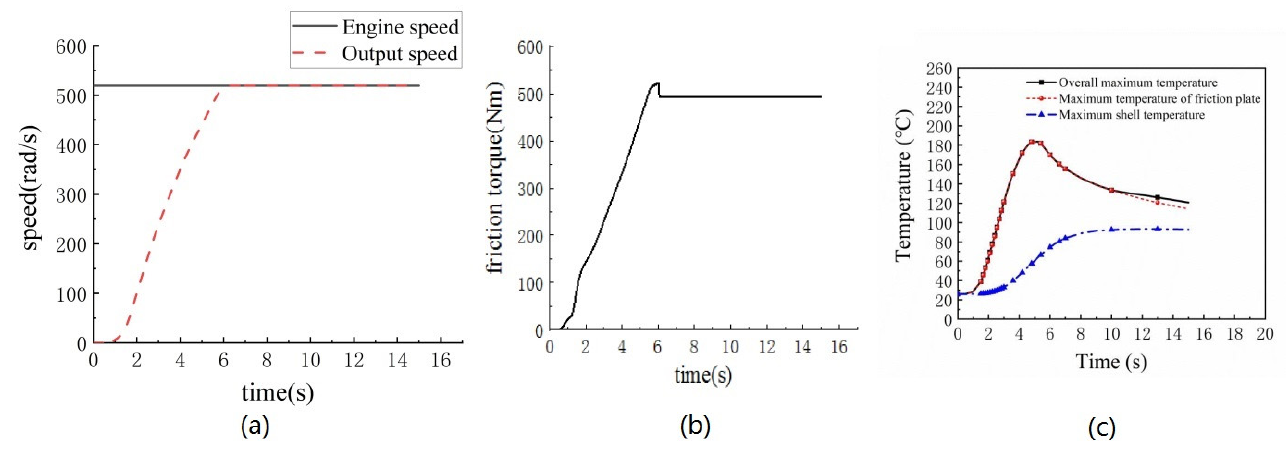
Figure 22. Variable slope pressure loading curve.